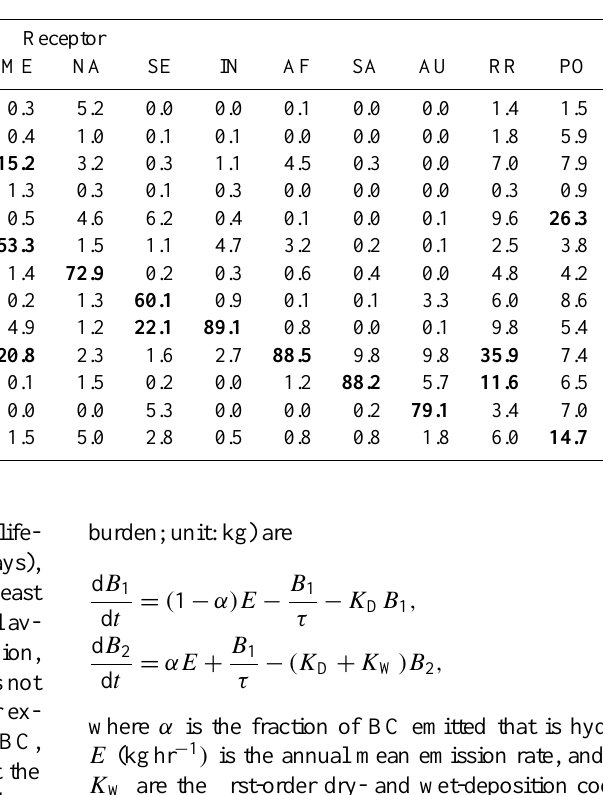
Table 2. Relative contribution (%) of emissions from 13 source regions to BC burden in the troposphere (200–1000hPa) over local and nonlocal receptors and to areas over the central Pacific Ocean (PO; 160 ◦ E–130 ◦ W and 60 ◦ S–58 ◦ N). Relative contributions that are more than 10% are highlighted in